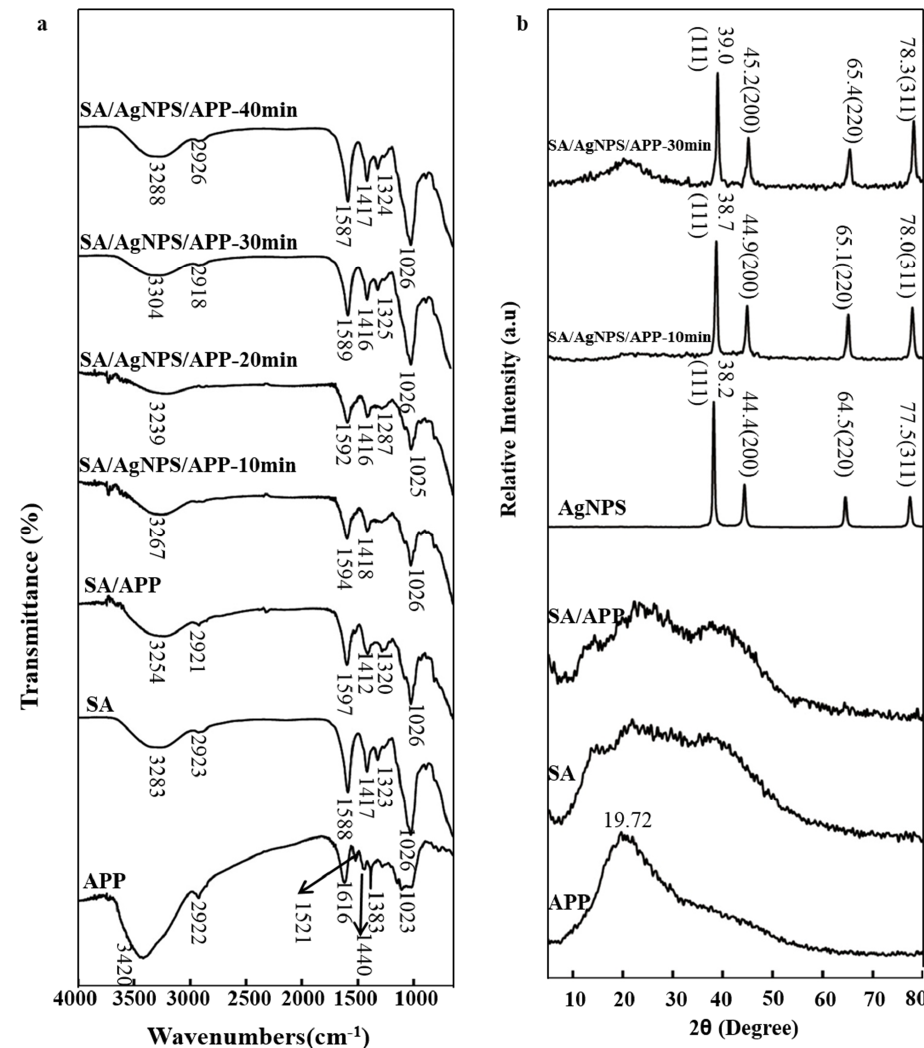
Figure 3. ( a ) FTIR and ( b ) XRD of SA, APP, Ag, SA/APP and SA/AgNPs/APP composite